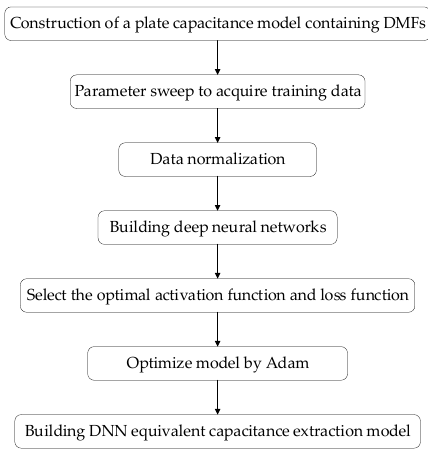
Figure 3. Flow chart for building DNN capacitance extraction model containing DMF.